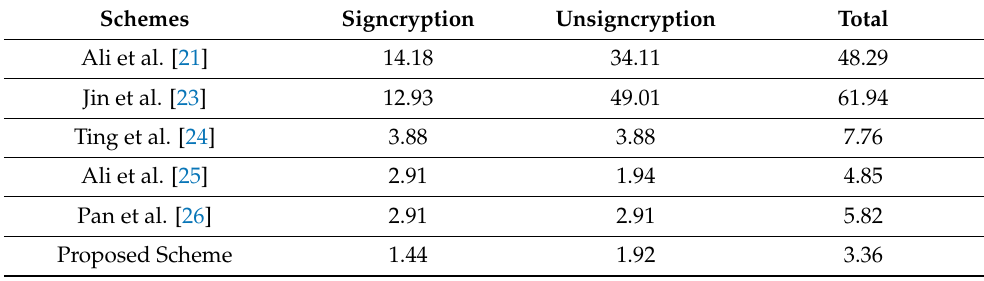
Table 4. Comparison of computation costs (in ms).